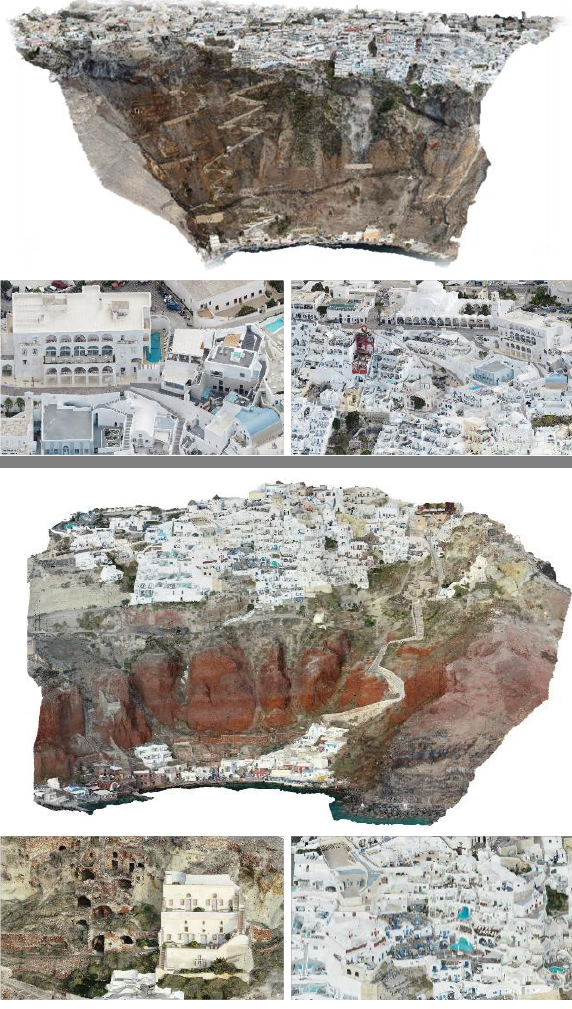
Figure 10. 3D reconstruction overview and details. Top : Fira village; bottom : OIA